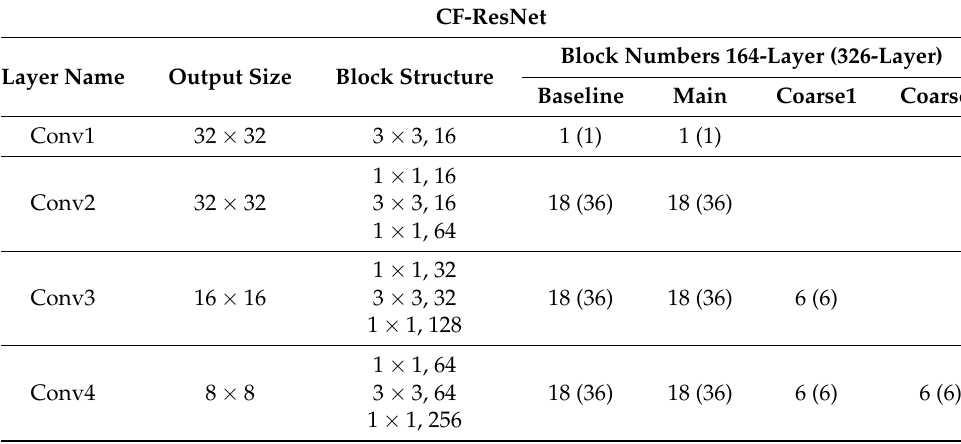
Table 2. Structure of the CF-ResNet model for CIFAR-10 and CIFAR-100